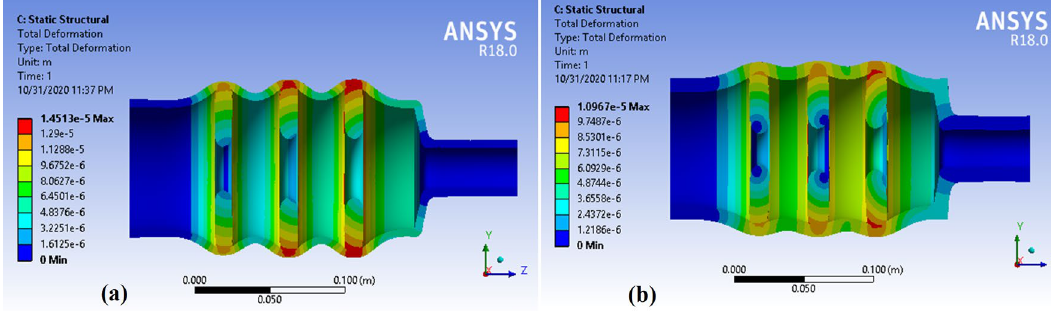
Figure 11. Total deformation of the cavities for two wall thicknesses of the cavity, a 5 mm and b 10 mm.